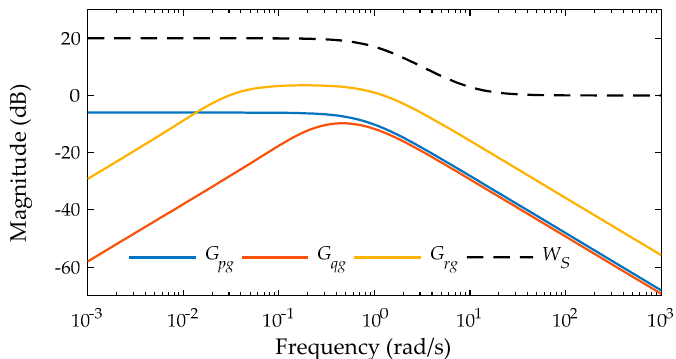
Figure 10. Dynamic characteristics of control system in frequency domain.